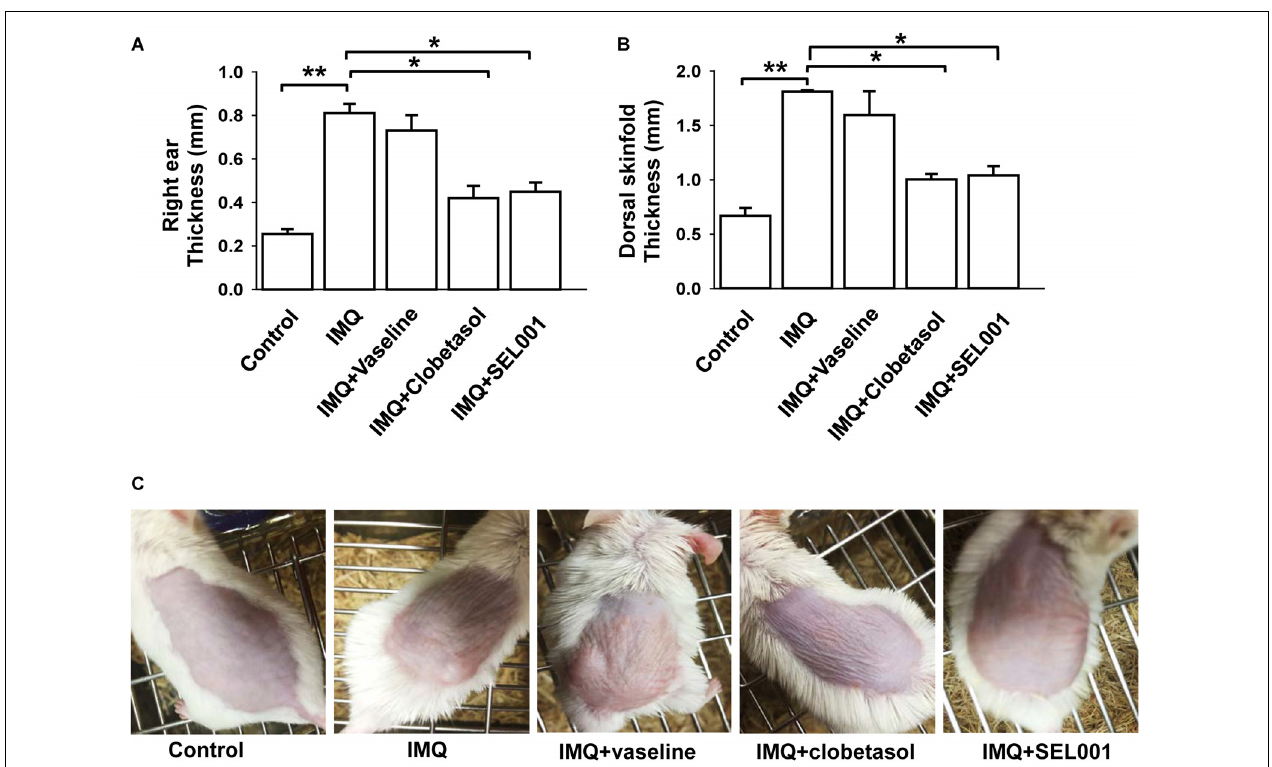
FIGURE 2 | Caliper measurement and visual appearance of skin. (A) Skin fold thickness on the backs of the mice, (B) right ear thickness, and (C) visual appearance on day 6. Columns represent means ± standard deviation of skin/ear measurements day 6. ∗∗ p < 0.001 or ∗ p < 0.05 is significant, analyzed by one-way ANOVA